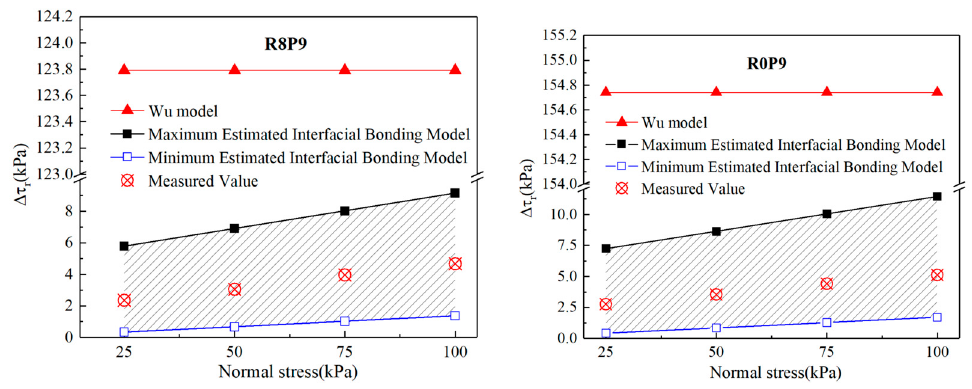
Figure 18. Comparison of measured and calculated values of the root reinforcement.